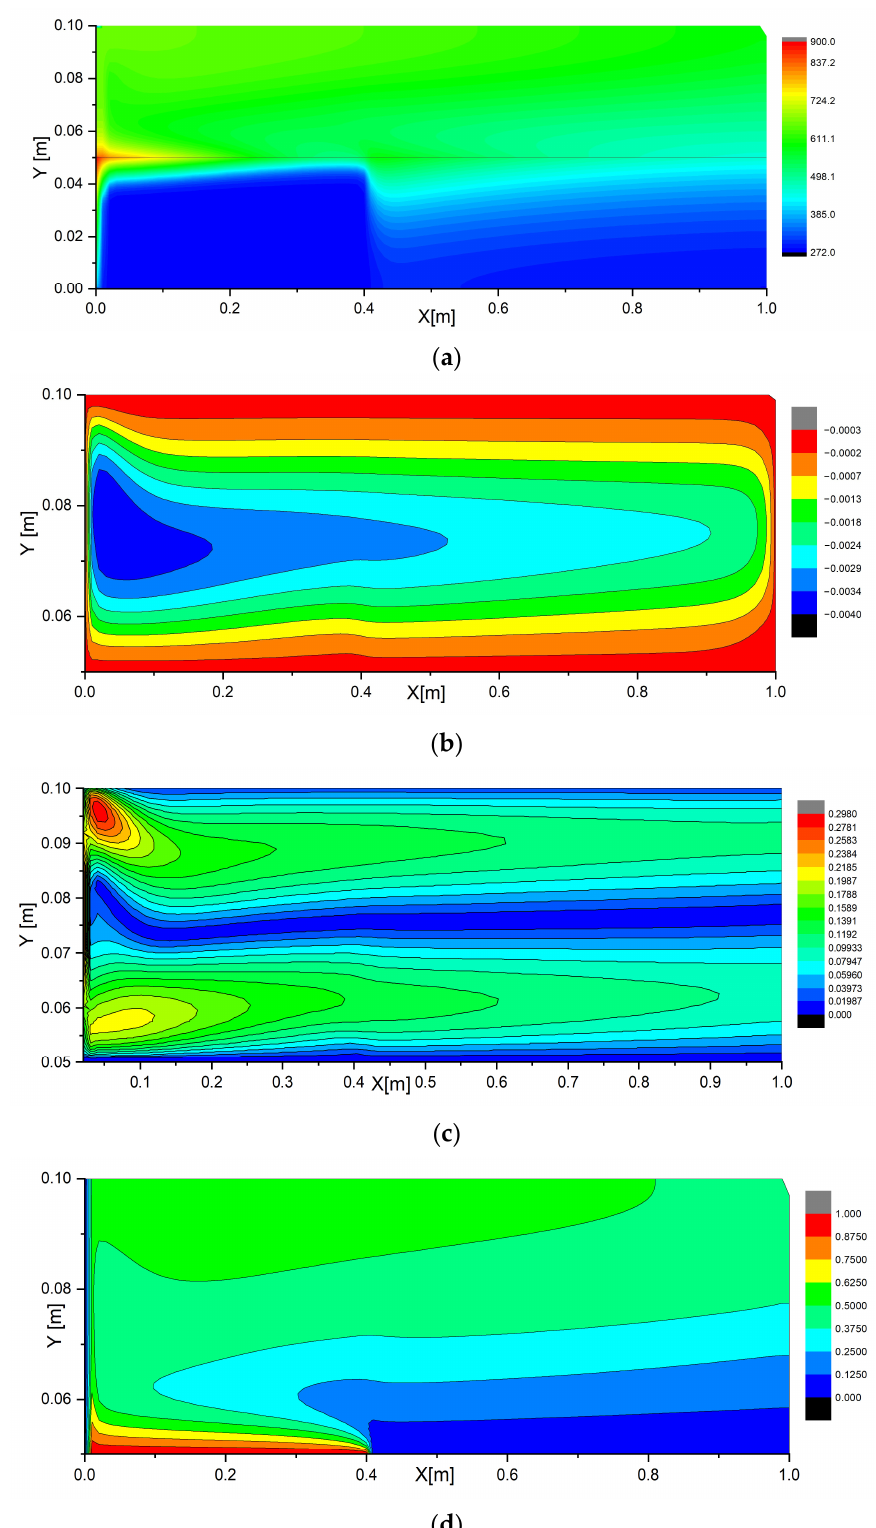
Figure 3. Temperature distribution ( a ) (K) in the forest fuel layer and in gas; contour lines of the stream function ( b ) (m 2 /s) of the mixture of air and water vapors near the forest fuel surface; contour lines of the velocity vector module ( c ) (m/s) near the forest fuel surface; mass concentration of water vapors in the air near the forest fuel surface ( d ).